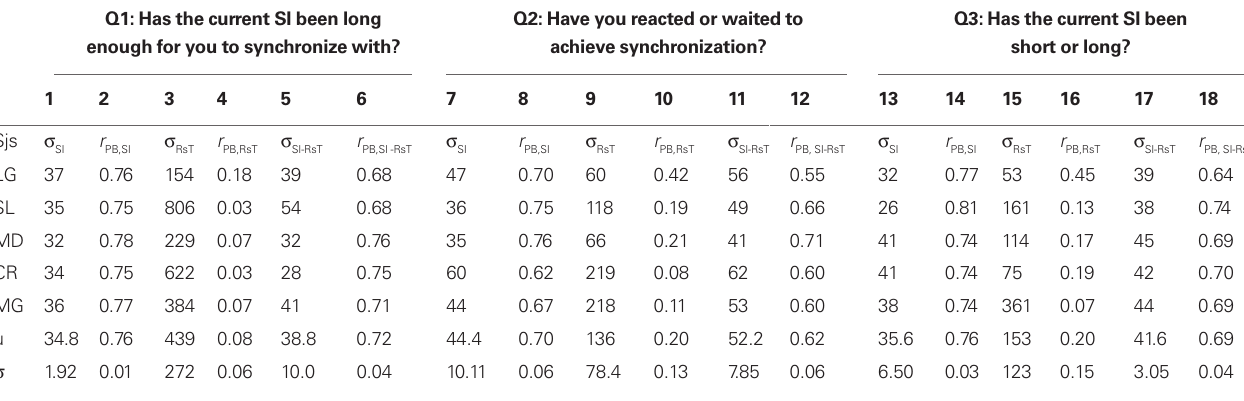
Table 1 | Standard deviations of the cumulative gaussians fitted to subjects’ “Yes” responses to each of the three questions asked in experiment 2 as a function of the synchronization interval ( σ ), response time ( σ rsT), and Si-rsT ( σ Si correlations ( r ; even PB